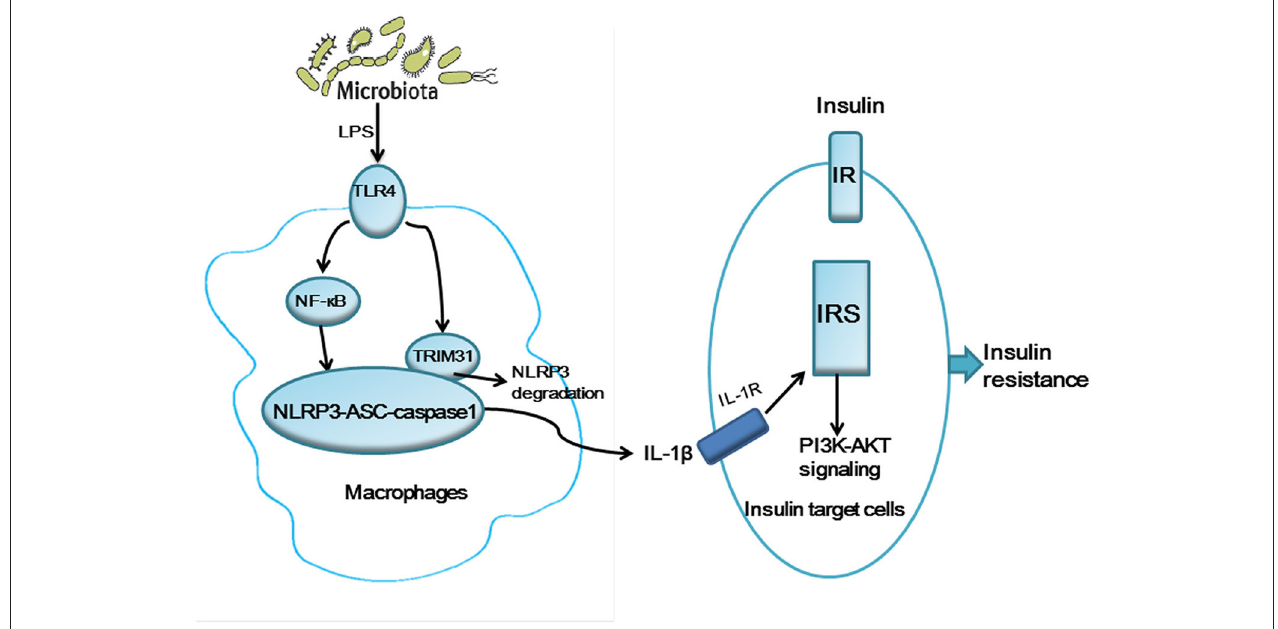
FIGURE 7 | A hypothetical model for the pathogenesis of glucose intolerance and insulin resistance in TRIM31 − / − mice. Gut microbiota may generate LPS inducing NLRP3 inflammasome activation and the release IL-1 β . TRIM31 binds to NLRP3 to promote proteasomal degradation of NLRP3. TRIM31 expression is markedly reduced in TRIM31 − / − mice, which promotes the release of IL-1 β . The activated IL-1 β induces insulin resistance by IRS1 and the PI(3)K–kinase Akt signaling pathway. LPS, lipopolysaccharide; IL-1 β , interleukin-1 β ; IRS1, insulin receptor substrate